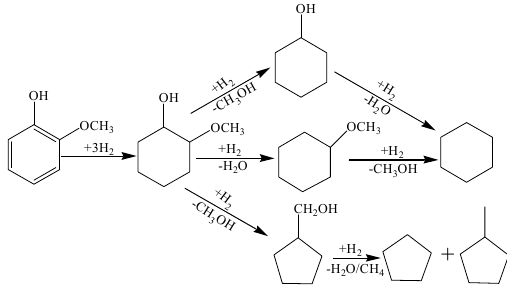
Scheme 1. Proposed main reaction pathways for the conversion of guaiacol with hydrogenation and deoxygenation on highly dispersed Ni/MCM ‐ 41 catalysts combined with HZSM ‐ 5.